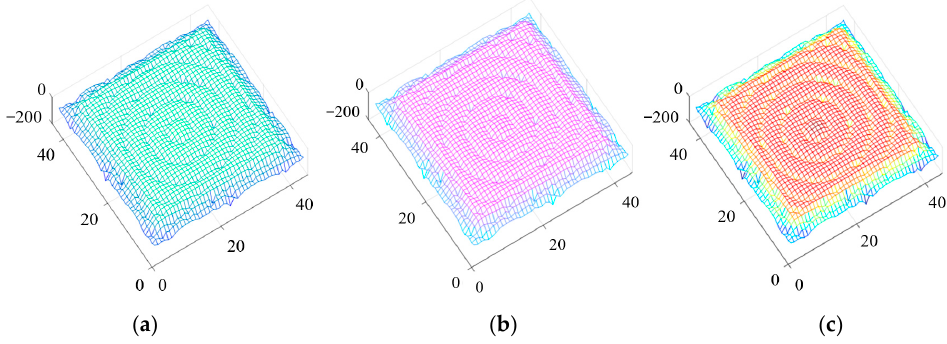
Figure 1. The field distribution in the computational domain calculated by using the dispersion HIE-FDTD method: ( a ) Drude model; ( b ) Debye model; ( c ) Lorentz model. The reflection error of the CPML boundary was quantitatively studied in this